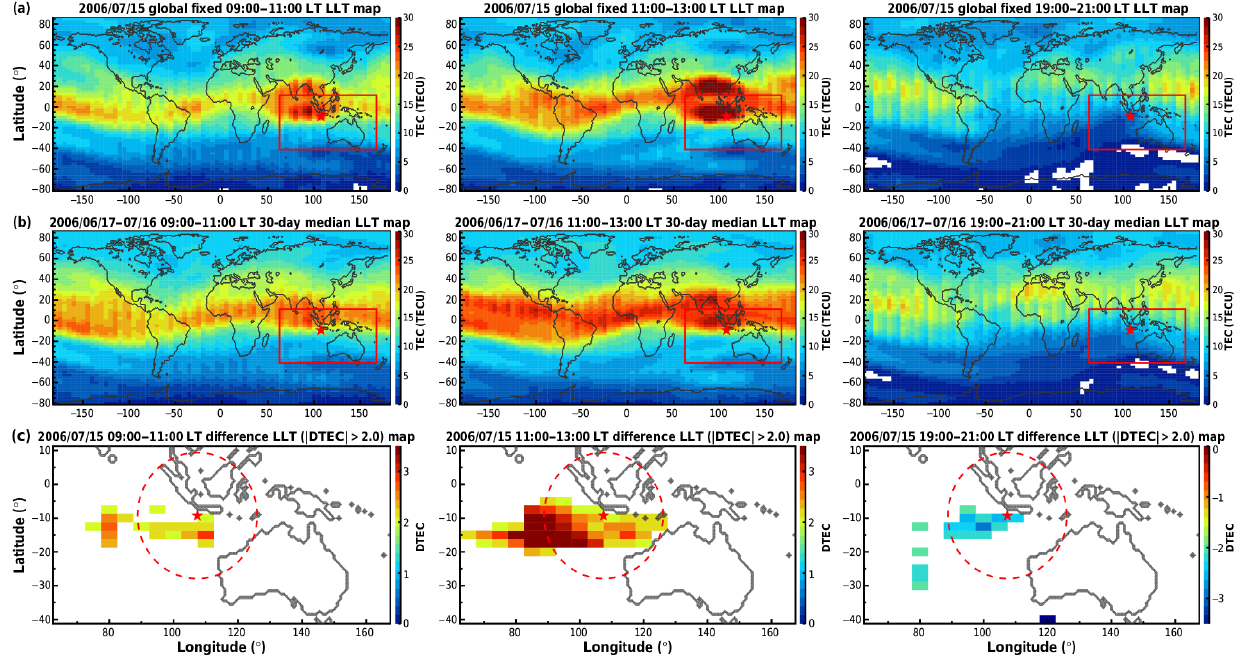
Figure 4. The GIM LLT maps observed during the global fixed period of 09:00–11:00, 11:00–13:00 and 19:00–21:00LT on day 2 before the 17 July 2006 M 7.7 south of Java earthquake. The GIM LLT maps during three global fixed local times: (left column) 09:00–11:00LT, (middle column) 11:00–13:00LT and (right column) 19:00–21:00LT, respectively. Panels of row (a) show the observed values on day 2 before the earthquake (15 July 2006), while those of (b) show the median values of the period of days 1–30 before (17 June to 16 July 2006) the earthquake. The red squares in rows (a, b) indicate the regions of interest around the earthquake, in the range of 41.25 ◦ S–11.25 ◦ N latitude and 62.5–167.5 ◦ E longitude. Panels of row (c) denote the extreme differences ( | DTEC | > 2 . 0 ) of the 30-day period, which appeared on 15 July 2006. The red dashed circles with the radius ρ = 2046 . 4km represent the earthquake preparation area of the lithosphere.